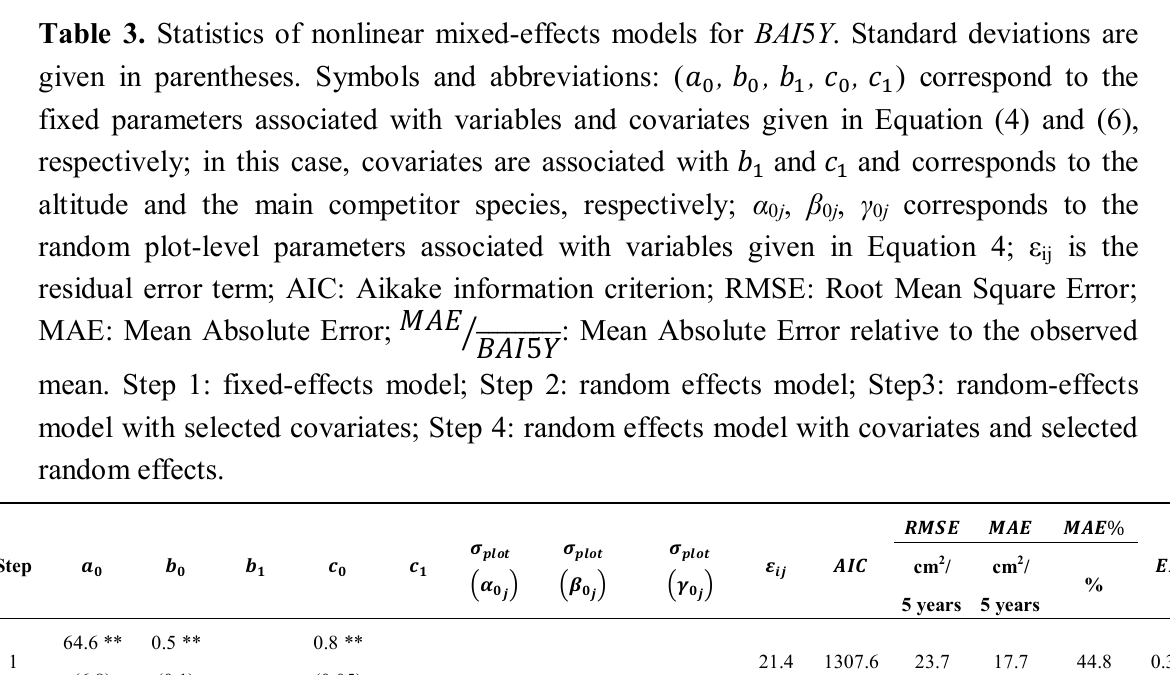
Table 3. Statistics of nonlinear mixed-effects models for BAI 5 Y . Standard deviations are given in parentheses. Symbols and abbreviations: ( , , , , ) correspond to the fixed parameters associated with variables and covariates given in Equation (4) and (6), respectively; in this case, covariates are associated with and and corresponds to the altitude and the main competitor species, respectively; α random plot-level parameters associated with variables given in Equation 4; ε